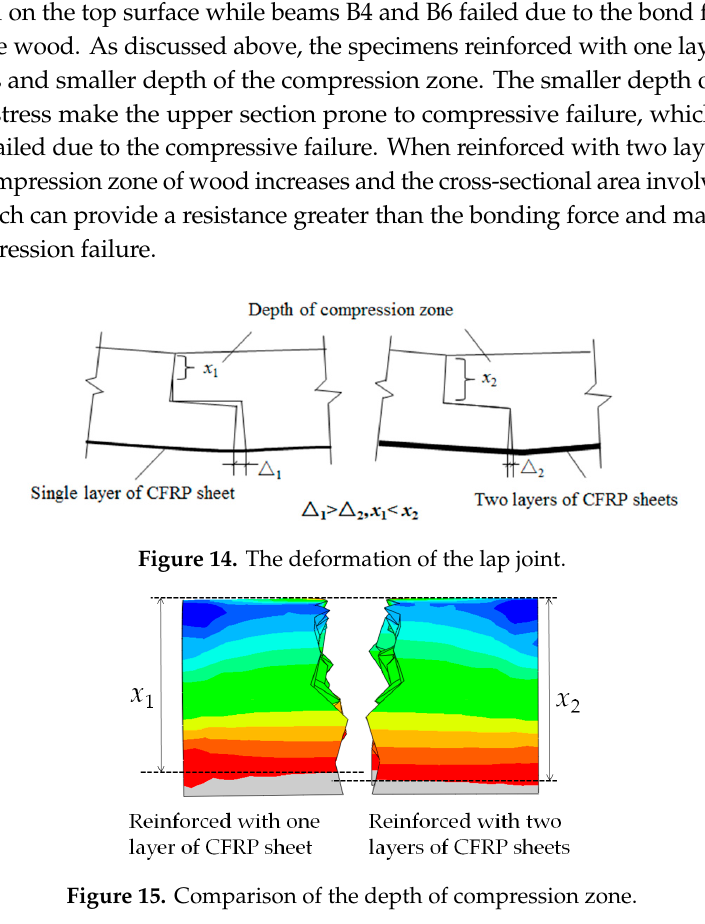
Figure 16. Strain profile for beams B5 and B6. ( a ) Beam B5 (reinforced with one-layer CFRP sheet); ( b ) beam B6 (reinforced with two layers of CFRP sheets). In addition, the location of the maximum stress in the numerical models and the location of the failure in experiments are highly consistent, which reveals that the numerical models also can be used to predict possible failure modes. Figure 17 shows the comparison between the stress contour and the failure modes of the specimens. According to the stress contour, the maximum compression stress occurred around the bolt hole. Beams B3 and B5 failed due to the compressive failure of wood near the bolt hole where the compressive stress is the largest. The maximum tension stress occurred on the longitudinal CFRP sheet near the seam of the lap joint, so the bond failure between the CFRP sheet and wood happened first near the seam of the lap joint. The rupture of longitudinal CFRP sheet also occurred near the seam of the lap joint where the tension stress is the largest. Although the finite elemental model in this study cannot simulate the failure mode, it can better predict the location and form of the failure.